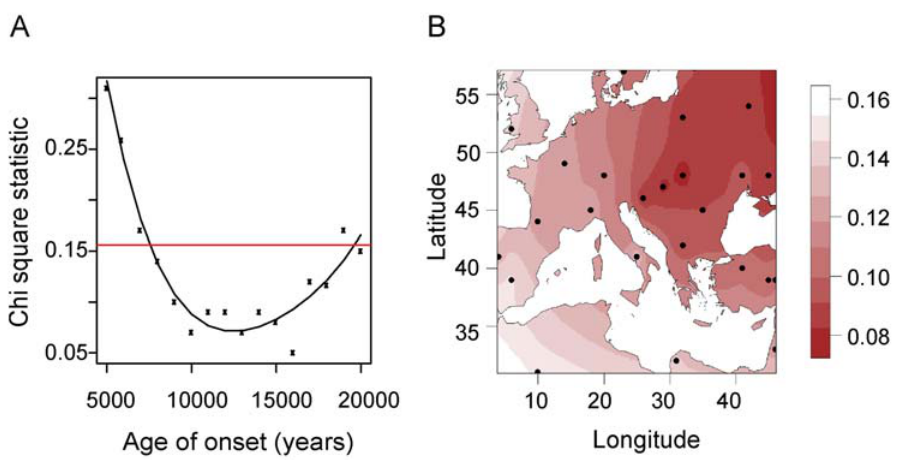
Figure 8. Chi-square statistic maps for spatial range expansion. (A) x 2 distances between the simulated and the empirical folded frequency spectra as a function of the time of onset of the expansion. The other parameters were fixed at m =0.25, r =0.6–1.2, and N 1 =10,000. The origin was placed north of the Black Sea (48 u N, 35 u E). The horizontal line corresponds to the 95% rejection interval of the x 2 test (df=3, see Methods). (B) Interpolated map of x 2 distances between simulated and empirical folded spectra for 24 potential origins (black dots). The time of onset was fixed at 9,000 years BP, and the other parameters were fixed as in (A).